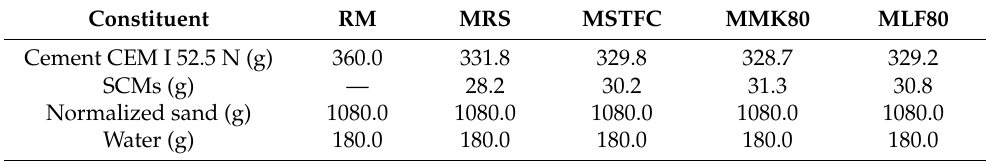
Figure 12. Relationship between the heat of hydration and time for RM, MRS, and MSTFC mortars. Table 6. Mortar composition of RM, MRS, and MSTFC for the heat of hydration test (NF EN 196-9)